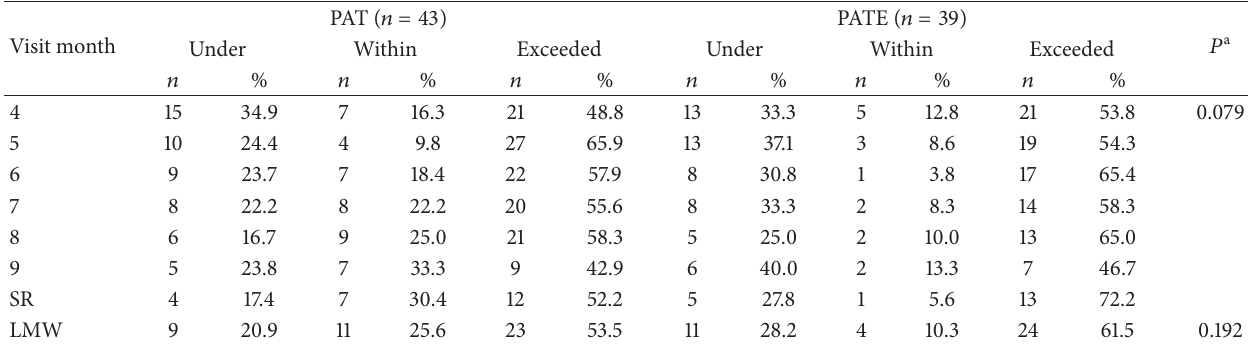
Table 4: Delta Healthy Sprouts participant IOM recommendation classification for gestational weight gain by visit and treatment. Visit month